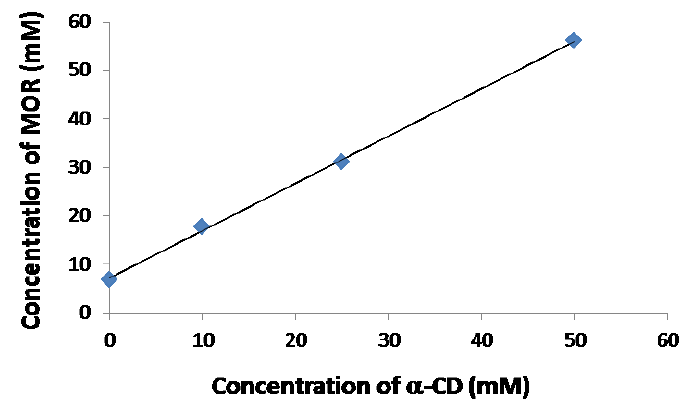
Figure 4. Phase solubility diagram of MOR in D 2 O solution in presence of α-CD obtained by 1 H-NMR (600 MHz, 300 K).